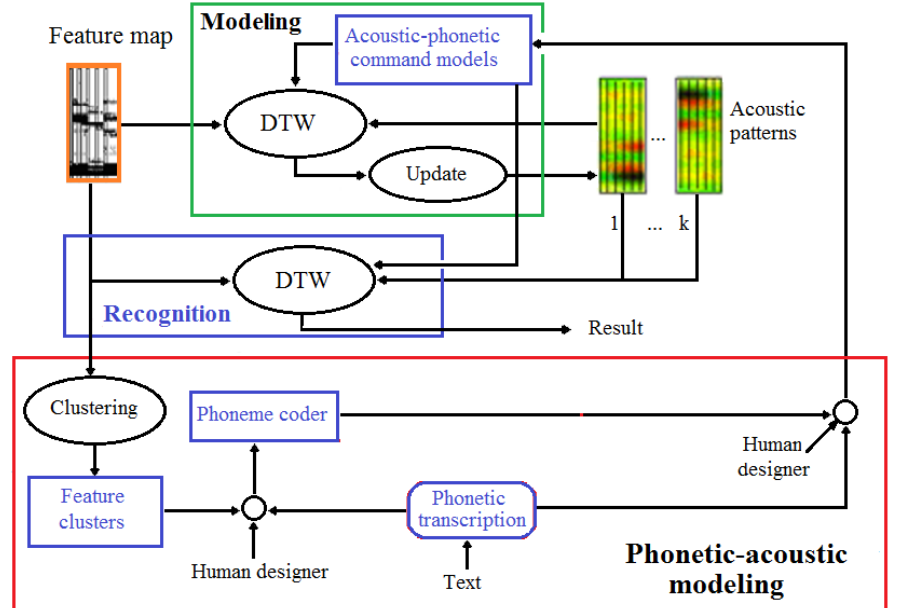
Figure 21. Command recognition structure utilising both the closed dictionary case (pure acoustic modelling) and open dictionary case (phonetic